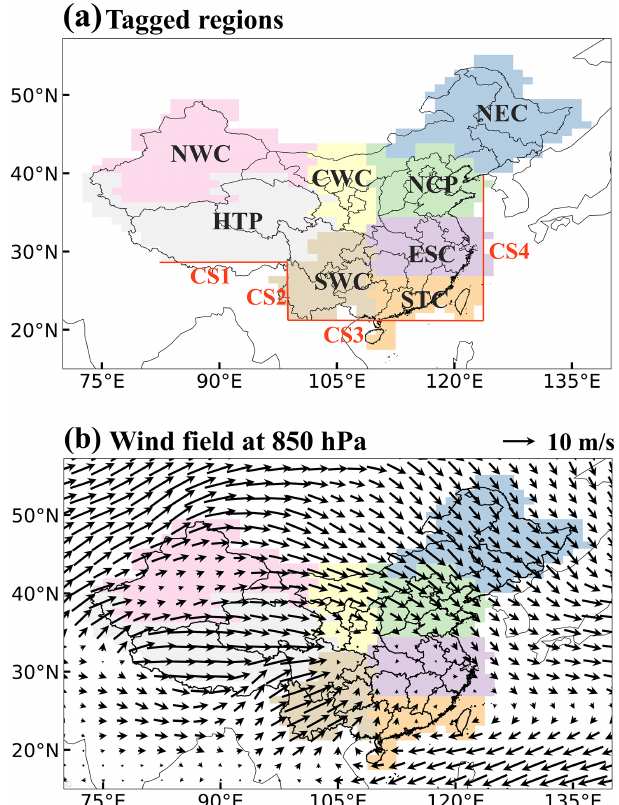
Figure 1. (a) Tagged source regions (NEC: northeastern China; NCP: North China Plain; ESC: eastern China; STC: southern China; CWC: central western China; SWC: southwestern China; NWC: northwestern China; HTP: Himalayas and Tibetan Plateau; ROW: rest of the world) and (b) mean wind field (units: ms − 1 , vectors) at 850hPa during the 3 weeks of the study from 30 January to 19 February, which had the largest number of newly diagnosed COVID-19 cases. Lines in (a) mark the cross sections (CS) defined to study the transport of aerosols to and from